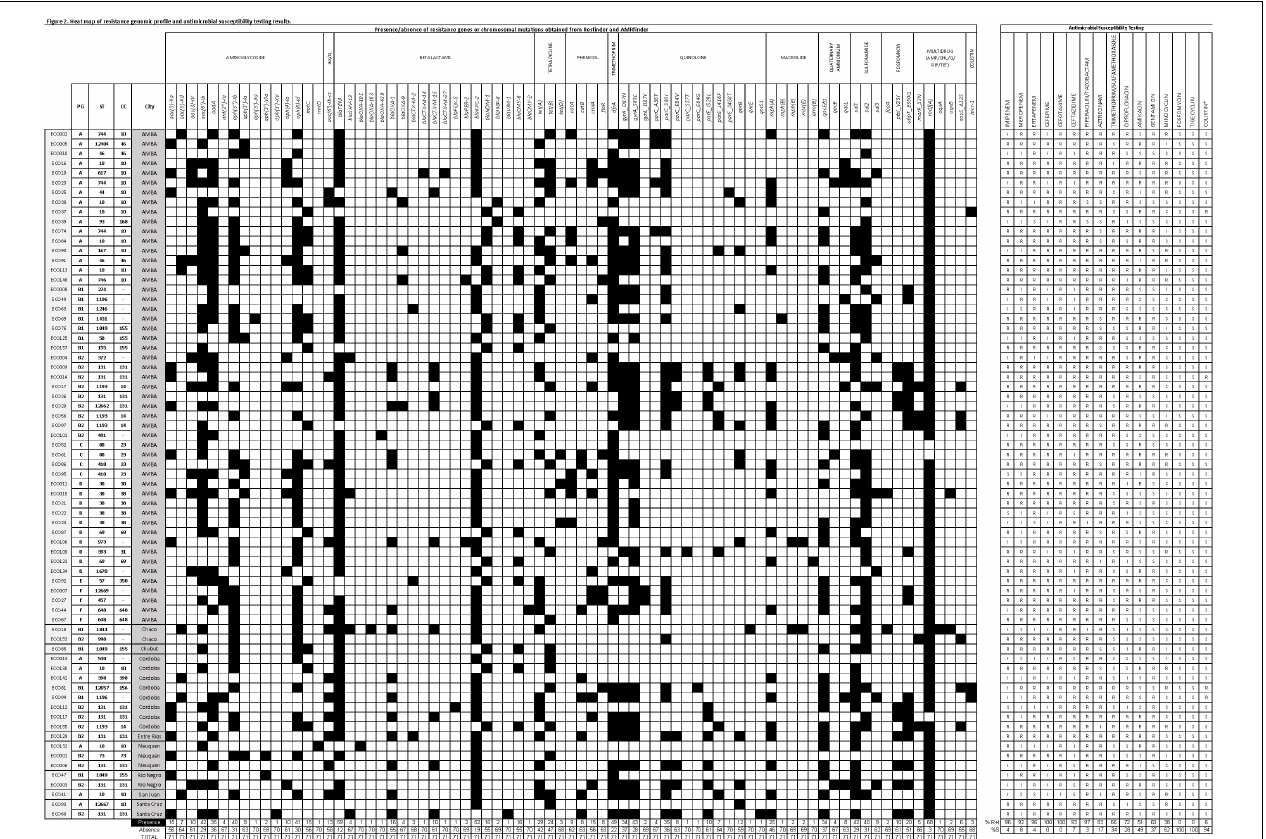
FIGURE 2 | Heat map of the resistance genomic profile and antimicrobial susceptibility testing results. The figure shows the presence and the absence of resistance genes or chromosomal mutations represented by black and white squares, respectively. The isolates were organized by geographic location. Column totals and percentages can be seen at the bottom of the figure. PG, phylogroup; ST, sequence type; CC, clonal complex; AG, aminoglycosides; Q, quinolone; AMP, ampicillin; CHL, chloramphenicol; RIF, rifampin; TET, tetracycline; R, resistant; I, intermediate; S,